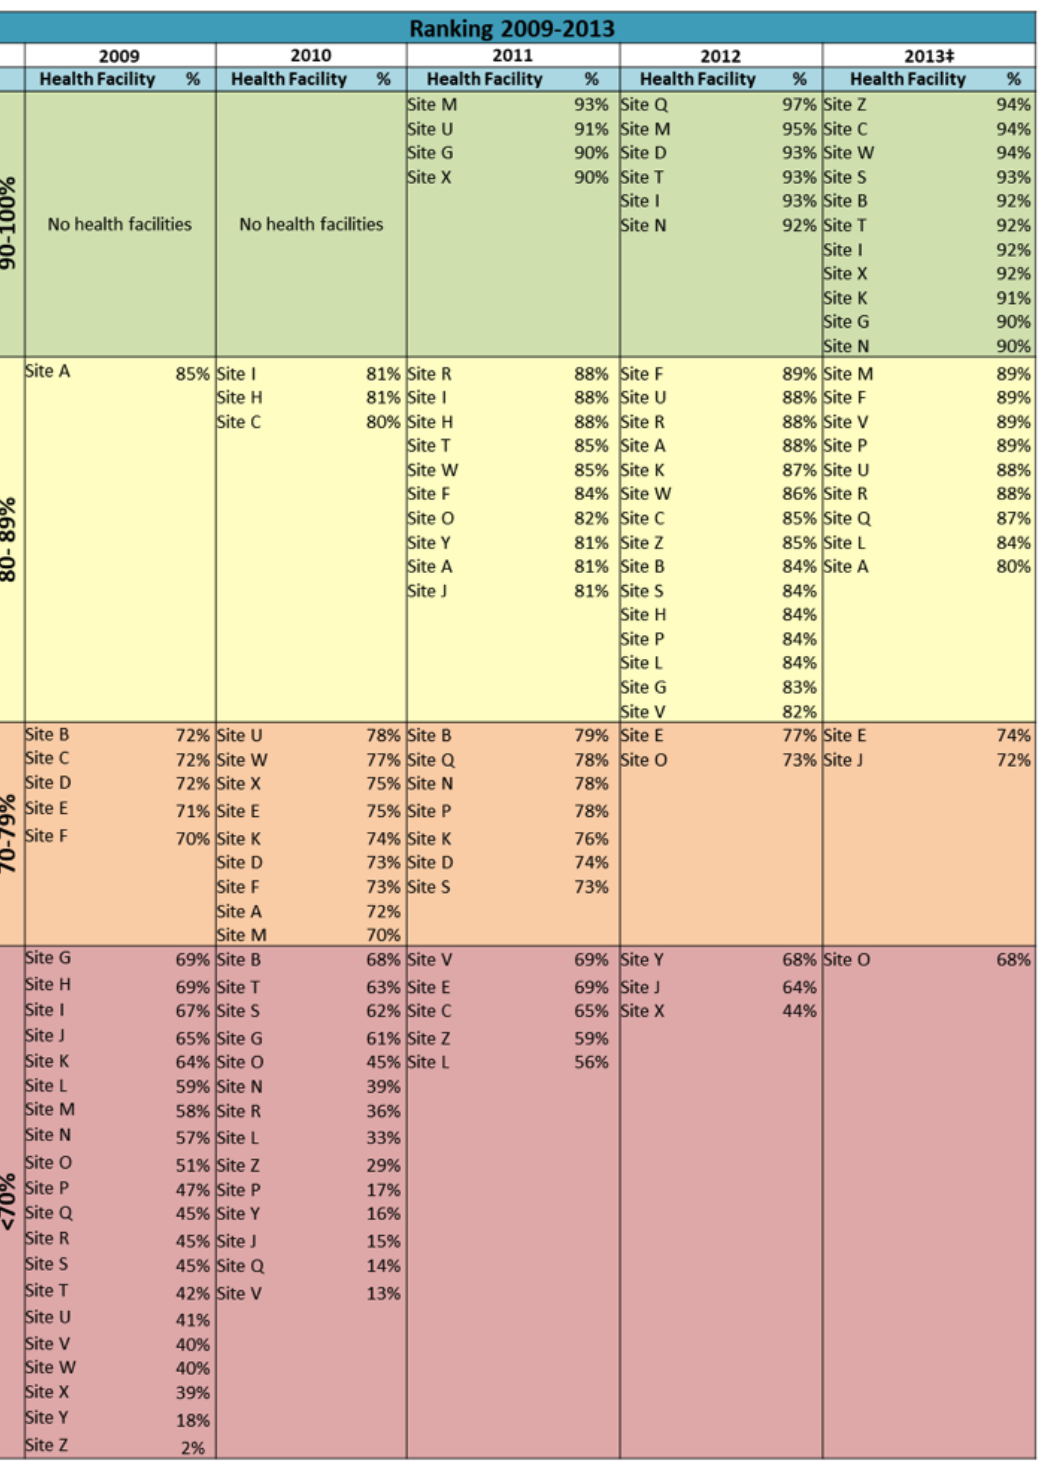
Figure 2. Annual data concordance across twenty-seven health facilities in Sofala Province, 2009–2013 (Gimbel